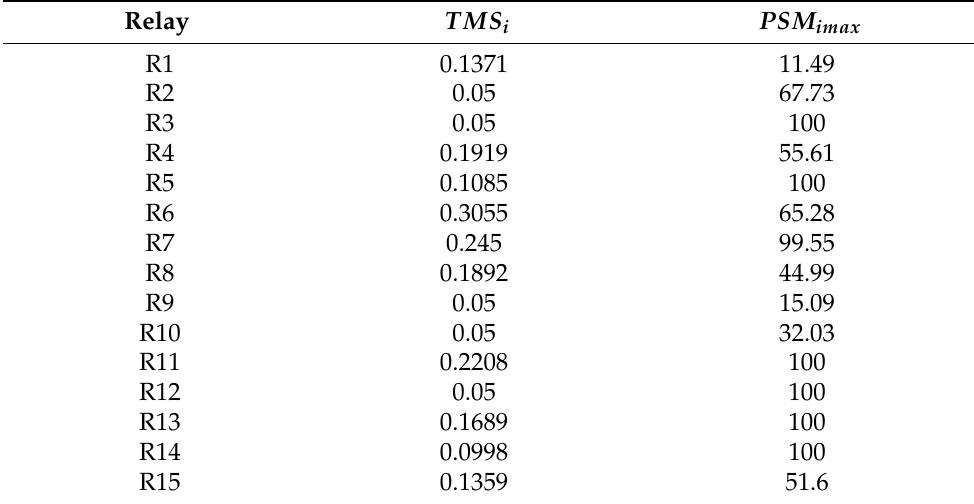
Table 5. Coordination parameters for Scenario 2.